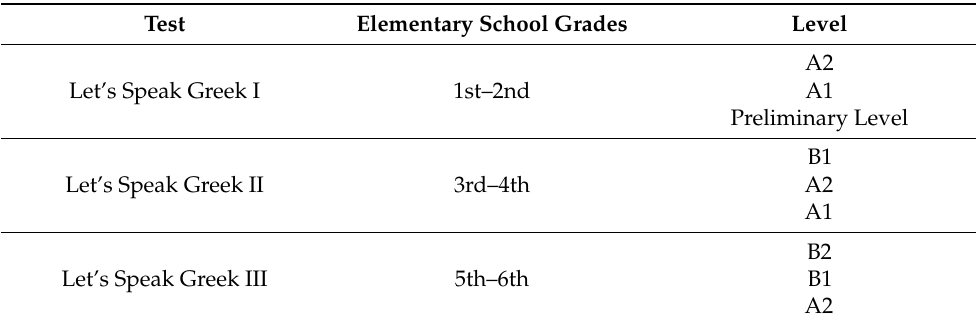
Table 2. Correspondence of tests, grades, and language level competence (as presented in Tzevelekou et al. 2008).